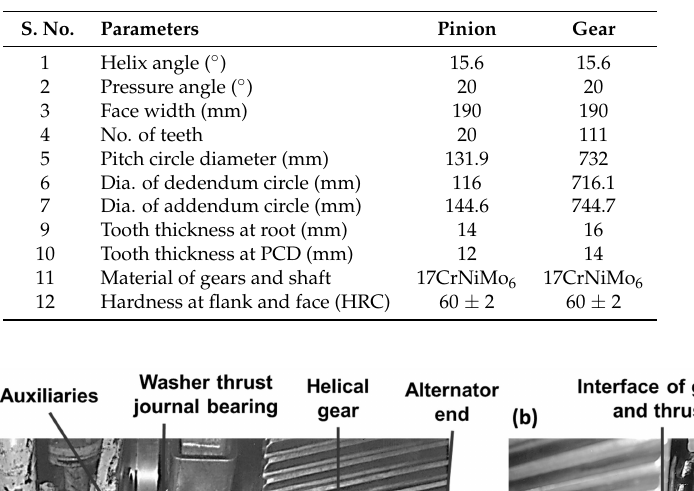
Table 1. Configuration data of pinion and gear collected at the site of the gearbox failure.